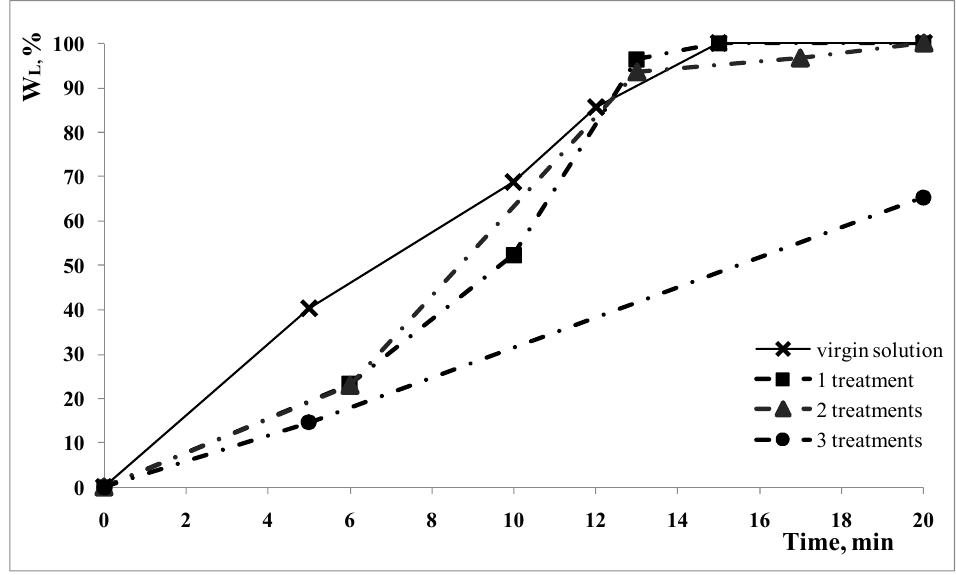
Figure 6. Percentage weight loss as a function of time for cleaning treatment with recycled solutions.